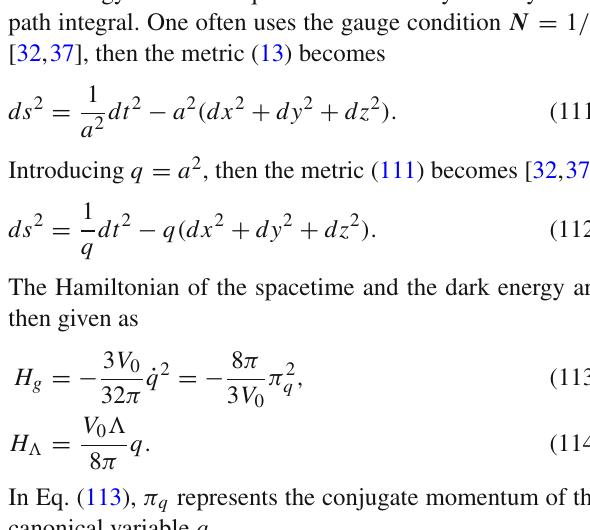
Fig. 25 Variations in the relative quantum fluctuation. The horizontal and vertical axes represent the time variable and relative fluctuation, respectively. The parameters are taken as: V 0 = 1, A 0 = 1, mN m = 10